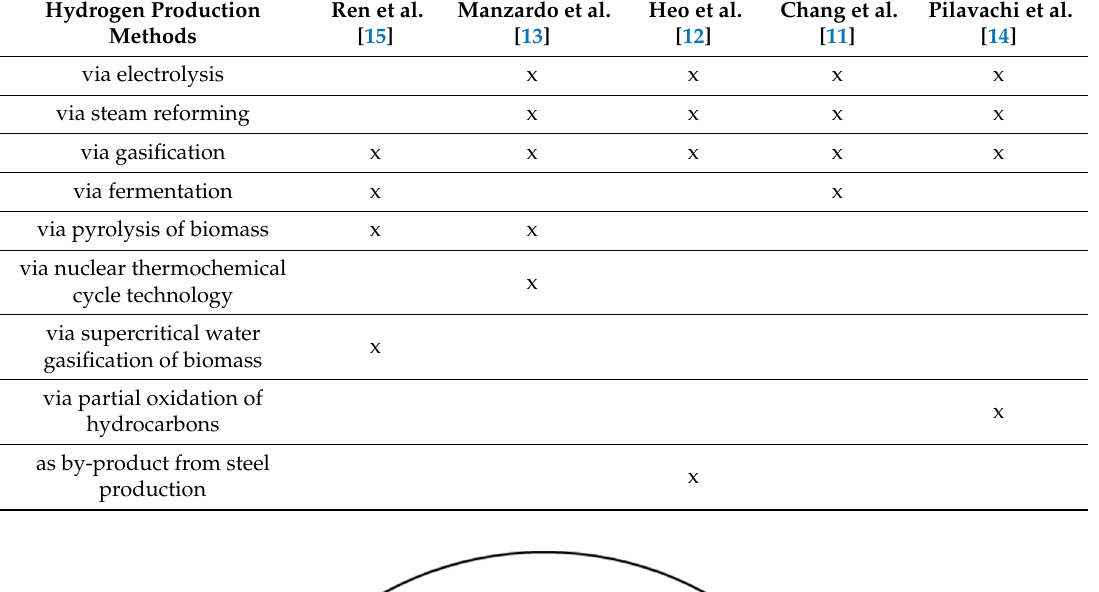
Table 7. Hydrogen production methods as analysed in the reviewed papers.